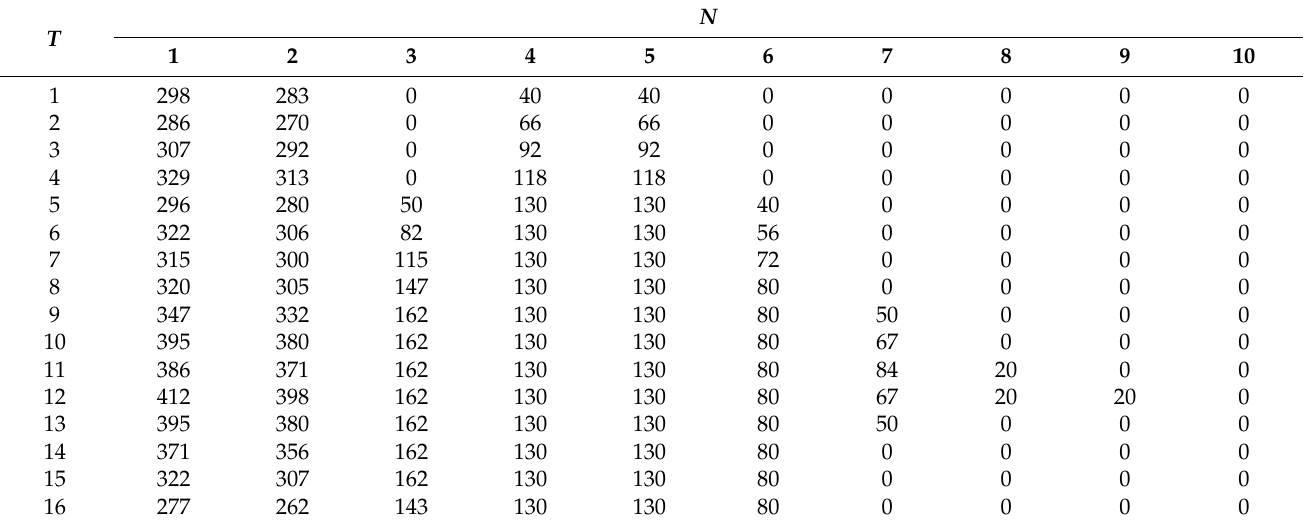
Table 5. System scheduling plan of 10 thermal power units in 24